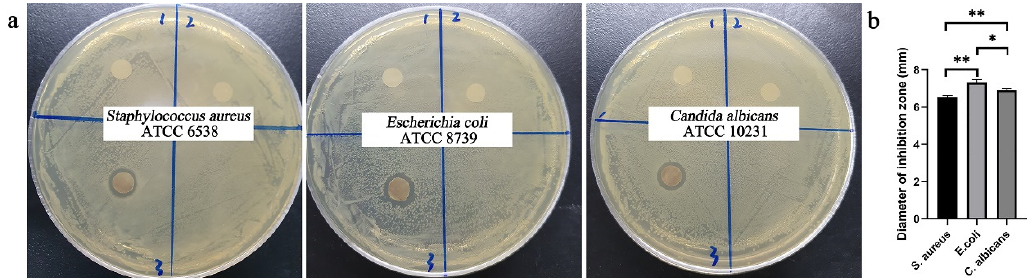
Figure 8. ( a ) Inhibition zones for neat PEO/PVA (1), HHK/PEO/PVA (2) and AgNP-HHK/PEO/PVA (3) nanofibrous mats against S. aureus , E. coli and C. albicans , and ( b ) the results analysis of the antibacterial test. *, p < 0.05; **, p < 0.01; n = 3.